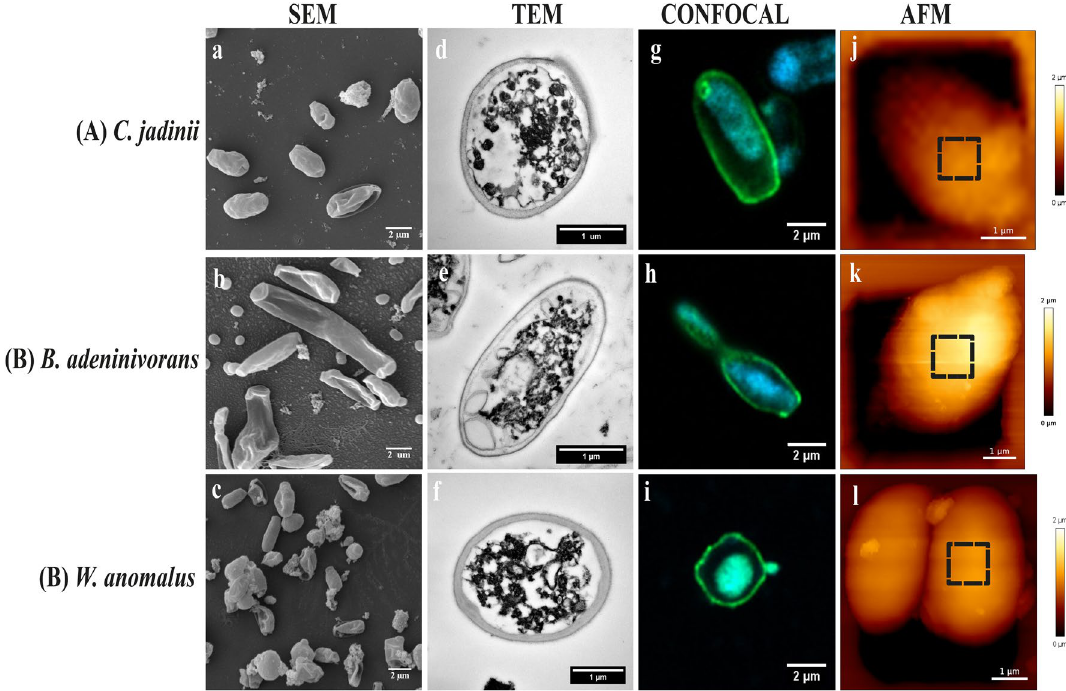
Figure 4. Cell surface architecture of three autolyzed yeast species (50 °C for 16 h) grown on sugars from lignocellulosic biomass. The pictures show Scanning Electron Microscopy ( SEM ; a – c ), Transmission Electron Microscopy ( TEM ; d – f ), Confocal microscopy (stained with concanavalin A-FITC for mannan) ( g – i ) and Atomic Force Microscopy ( AFM ; height) ( j – l ) micrographs of Cyberlindnera jadinii ( panel A ), Blastobotrys adeninivorans ( panel B ) and Wickerhamomyces anomalus ( panel C ). The SEM and TEM micrographs were taken on yeast creams (before drying), whereas the confocal and AFM micrographs were taken on dried yeast samples, as described in the ‘Material and Methods’. The dotted squares on the AFM height micrographs represent the spots where mapping was done for determination of the Young modulus and measurement of adhesion events, as described in ‘Material and